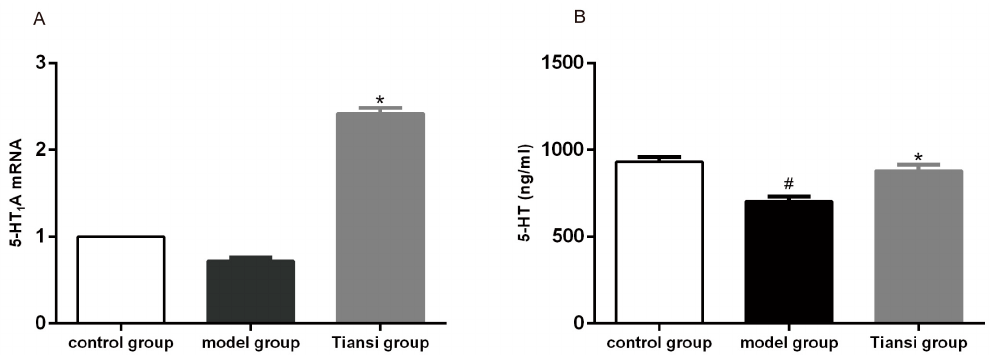
Figure 3. Effects of Tiansi Liquid on 5-HT 1A receptor expression and plasma 5-HT concentration. 5-HT 1A mRNA levels ( A ) and plasma 5-HT concentration ( B ) in the three groups. There were ten rats in each group. Statistical analyses were performed using one-way ANOVA and Tukey—Kramer post hoc comparisons. # p < 0.05, vs. control group; * p < 0.05, vs. model group.